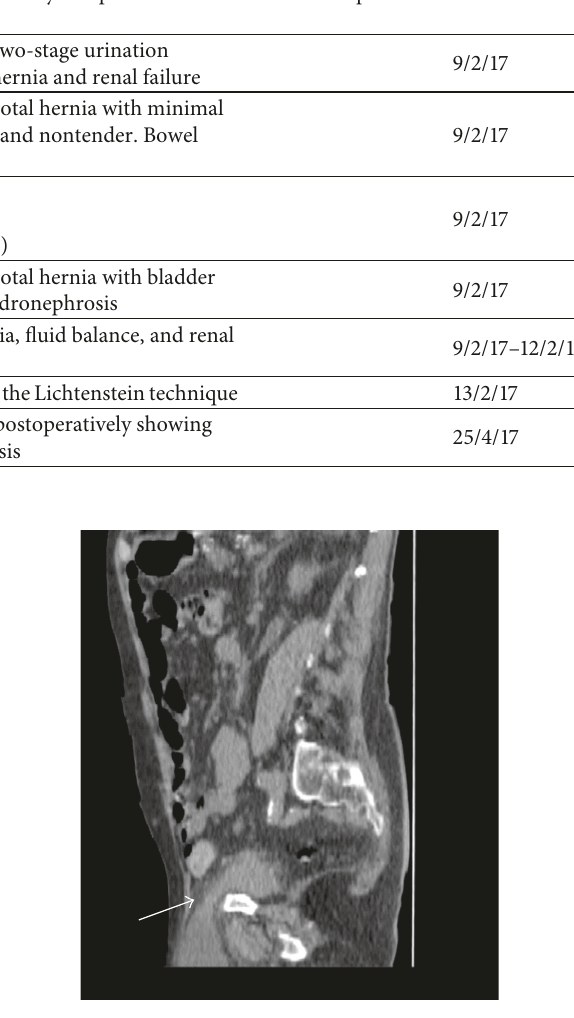
Figure 2: Sagittal CT section showing bladder